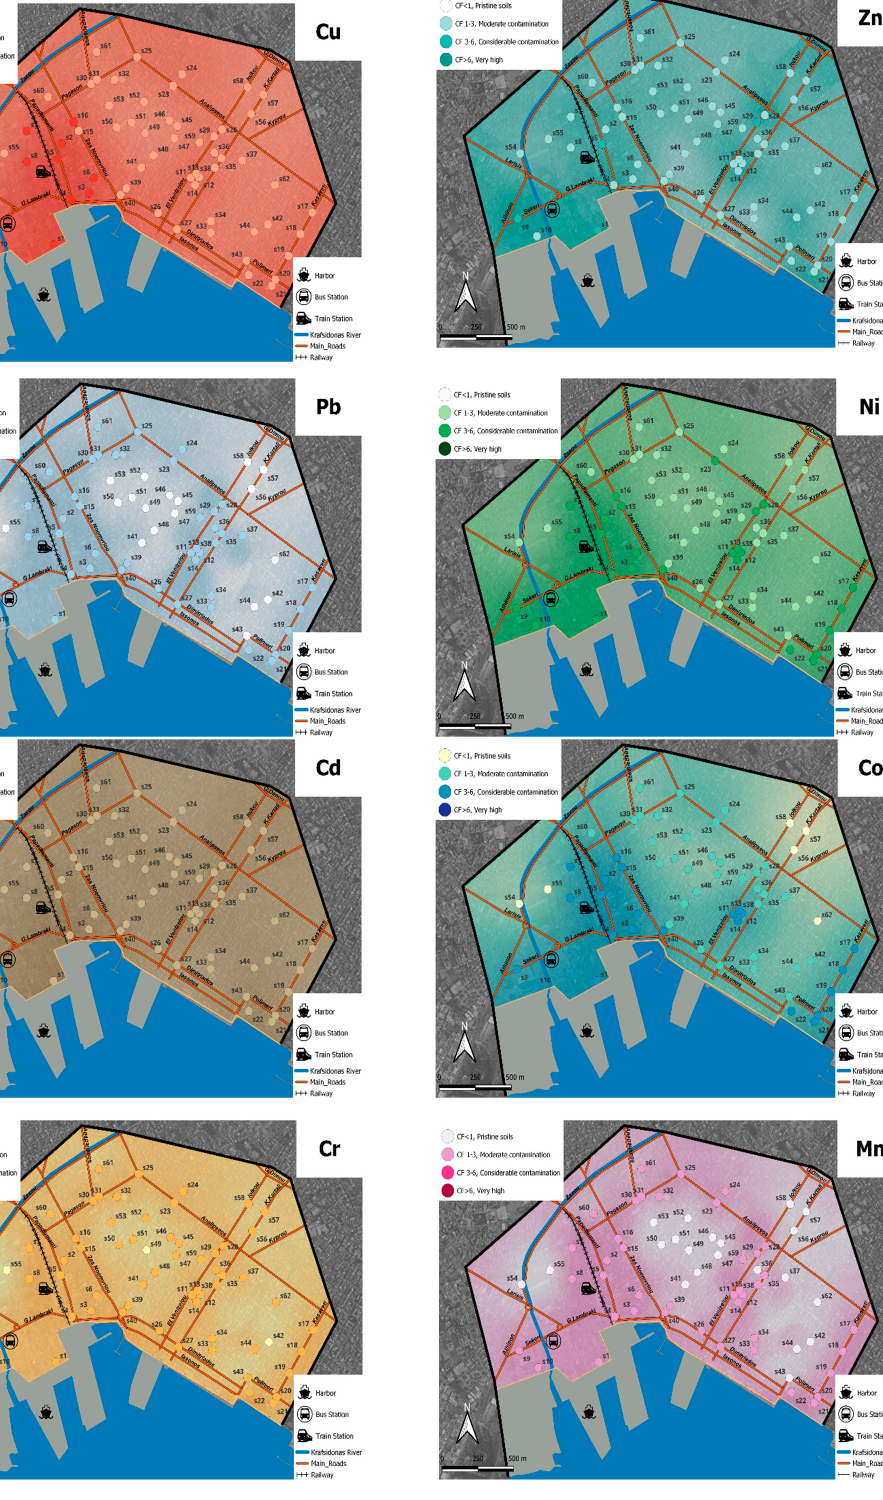
Figure 1. Thematic maps of heavy metals based on contamination factor (CF) values in Volos before the COVID ‐ 19 pandemic (mean values for the four years of the study, n = 248).